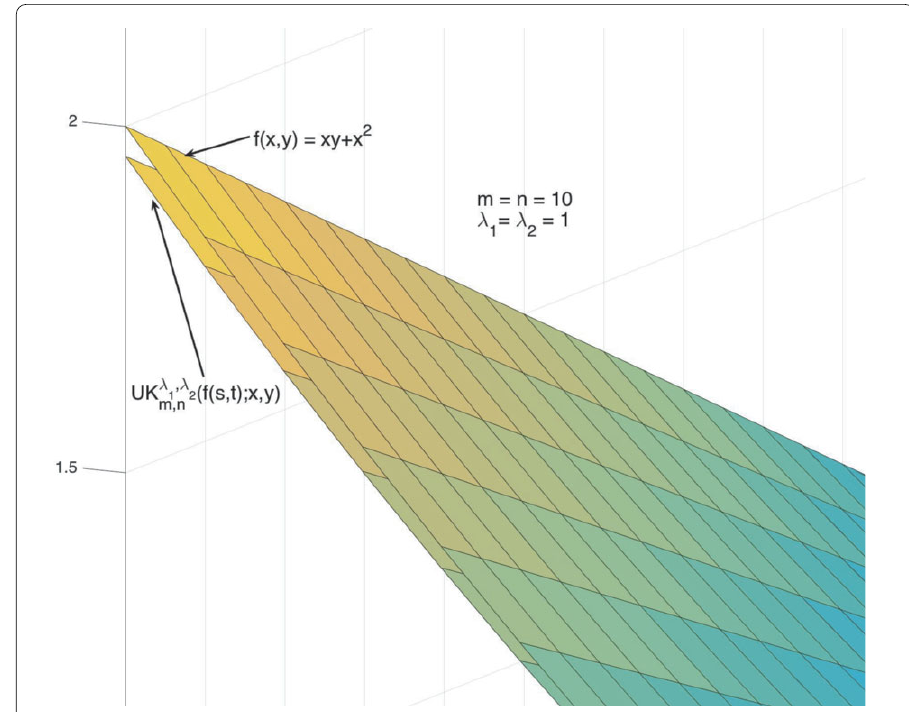
Figure 2 Partially enlarged graphs of UK 1,1 10,10 ( f ( s , t ); x , y ) and f ( x , y